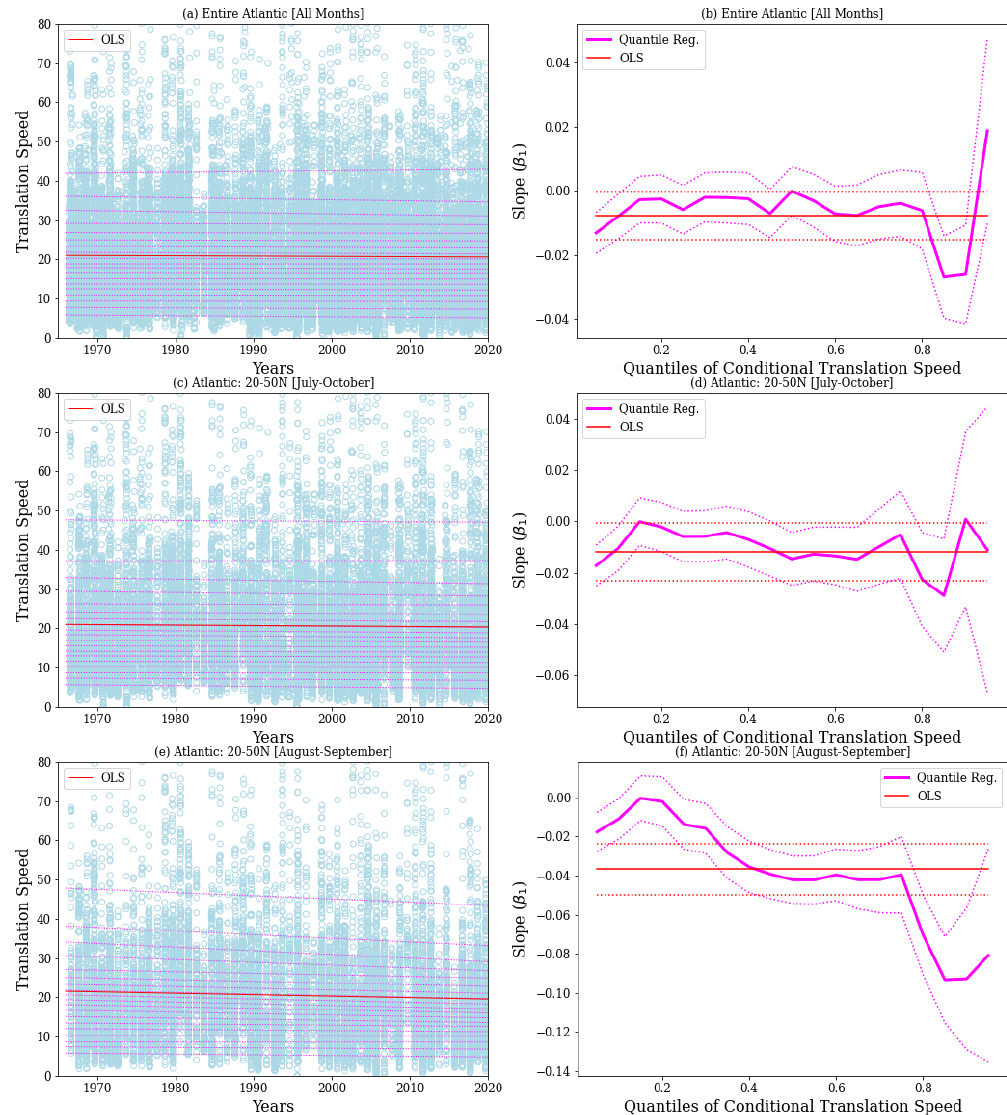
Figure 15. As in Fig. 13 but for translation